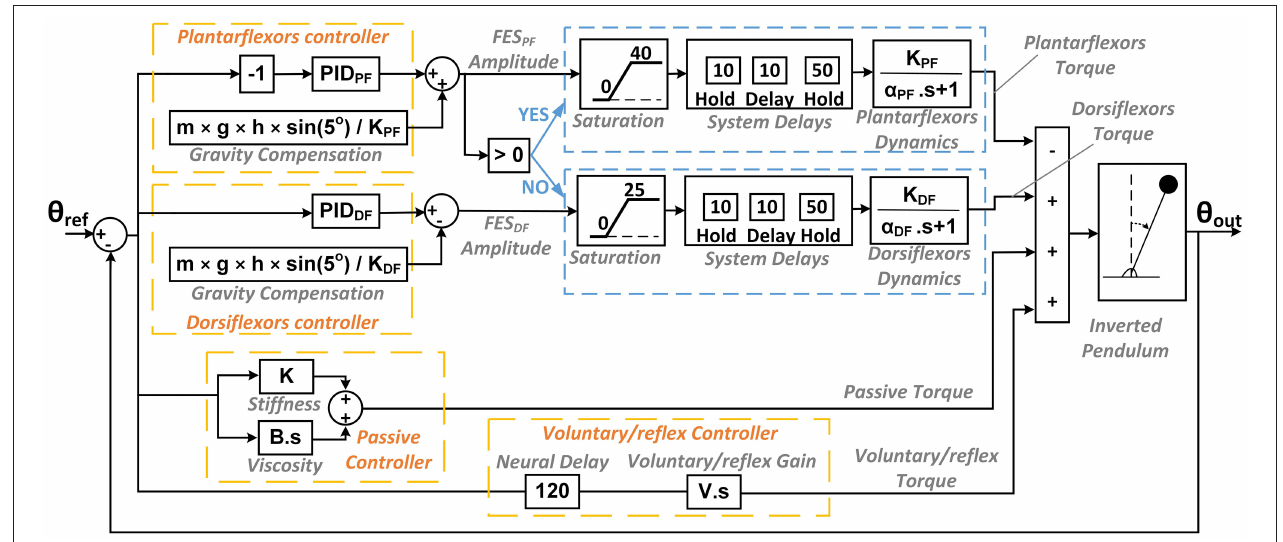
FIGURE 3 | The controller model used in the simulation including the two PID controllers, the gravity compensation component and the mechanism for switching between muscles, and other components added to the controller depicted in Figure 2 in order to model the experimental behavior of the system.